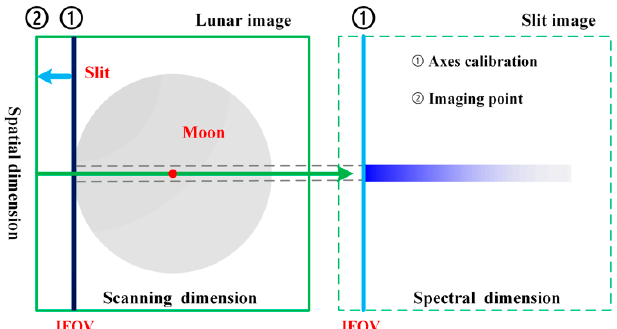
Figure 2. Accurate pointing setting of the imaging spectrometer. ( 1 ) Calibration point of the optical axis parallelism; ( 2 ) Initial point of the moon imaging.